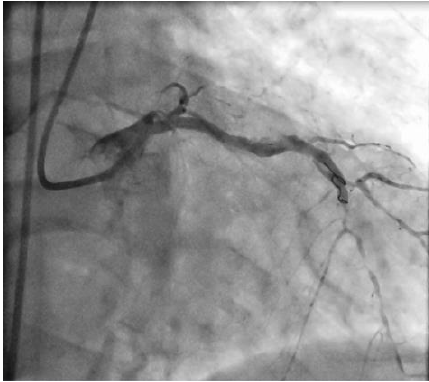
Figure 6. Coronary angiogram post-stent graft implantation showing the complete exclusion of the aneurysmal sac (dissection flap is seen at the mid part of the left anterior descending